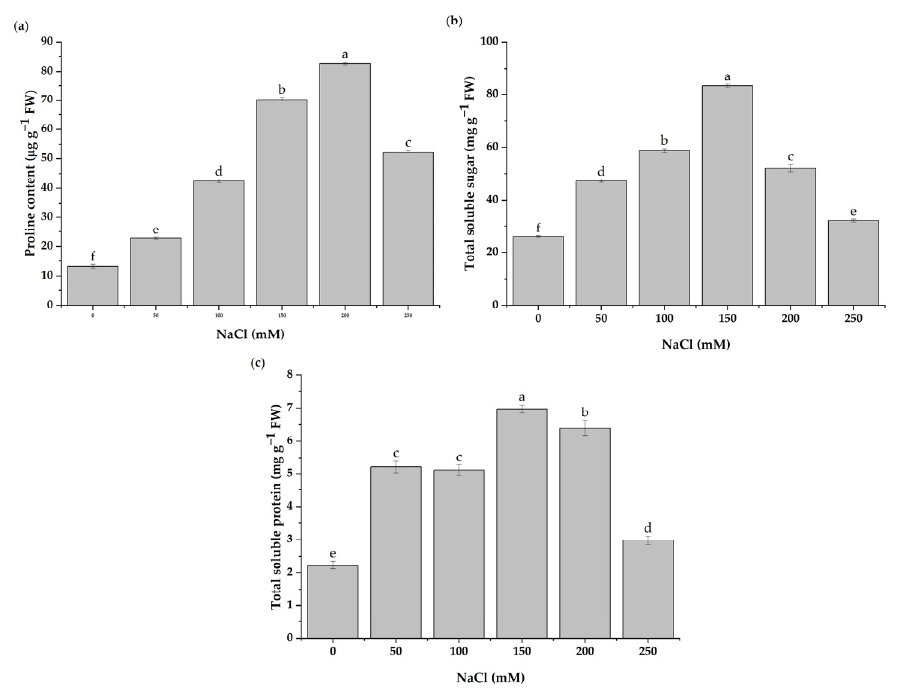
Figure 3. Effects of salt stress on the proline ( a ), total soluble sugar ( b ), and total soluble protein ( c ) contents in leaves of H. cannabinus seedlings subjected to 0, 50, 100, 150, 200, and 250 mM of NaCl. The values shown are means ± SD ( n = 3). The different letters (a–f) above the bars indicate a significant difference according to the Duncan test ( p < 0.05).